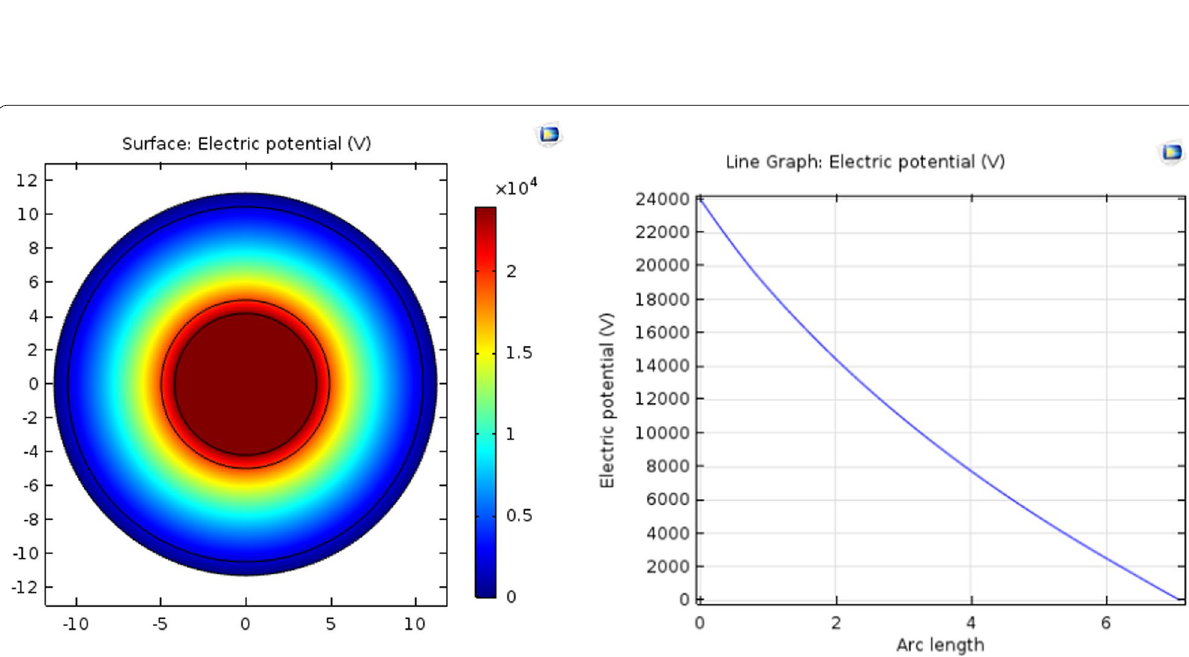
Conclusion The maximum uniform electric field was found in the mid- dle of the XLPE/5-ZnO 25 kGy film sample, rather than at the top or bottom, according to the results. This might be attributed to a significantly low relative permittivity of